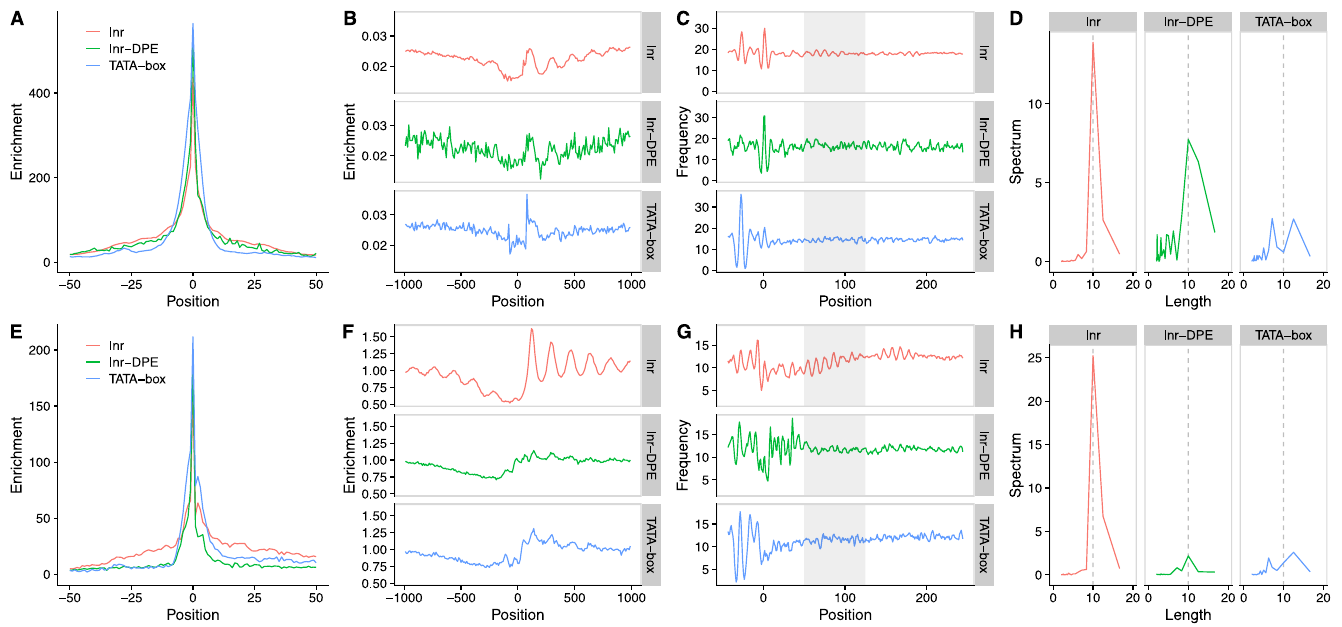
Fig 5. Promoter classes architecture. For Homo Sapiens (A-D), Inr and Inr-DPE classes correspond to Class 1 and Class 3 as in Fig 3, respectively. For Drosophila melanogaster (E-H), Inr class correspond to Fig 2 Class 2 and 3, while Inr-DPE class corresponds to Class 1 of the same figure. TATA-box annotation was derived from the EPD database. CAGE distribution around Homo sapiens (A) and Drosophila melanogaster (E) transcription start sites (TSS) stratified by presence of core promoter elements. CAGE data was retrieved from the FANTOM consortium [66] and Machibase [67] for Homo sapiens and Drosophila melanogaster , respectively. To reduce the impact of highly expressed promoters, CAGE tags mapping to the same location have been capped to 1000. The presence of the DPE element has a stronger effect on D . melanogaster promoters in focusing the initiation, compared to human. (B and F) Nucleosome distribution around Homo sapiens (B) and Drosophila melanogaster (F) TSSs stratified by the presence of promoter elements as in A and E. Inr promoters show an open chromatin configuration in both organisms, whereas TATA-box and Inr-DPE promoters demonstrate a closer conformation. (C and G) Nucleosome favoring signals as described in [11] around Homo sapiens (C) and Drosophila melanogaster (G) promoters, stratified as in A and E. For both organisms, it is evident that a strong 10bp periodic signal present in Inr promoters is strongly reduced by the presence of the Inr-DPE or the TATA-box. (D and H) Fourier transform to quantify the periodic signal strength is shown in C and G (area used in this analysis is marked by gray boxes). Numerical data are provided in S2